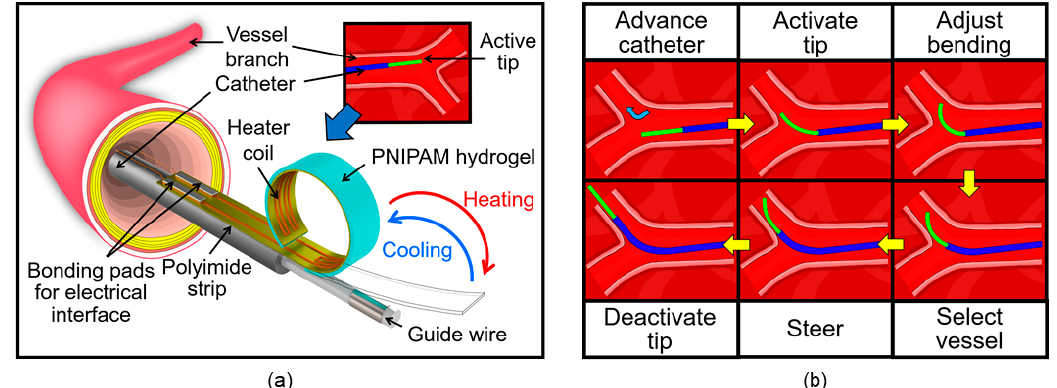
Figure 1. Conceptual diagrams of the steerable smart catheter tip: ( a ) Device structure and operation (illustrated for an example in blood vessel application); ( b ) an illustration on how the smart tip aids in maneuvering to an intended vessel branch while navigating through the human body.